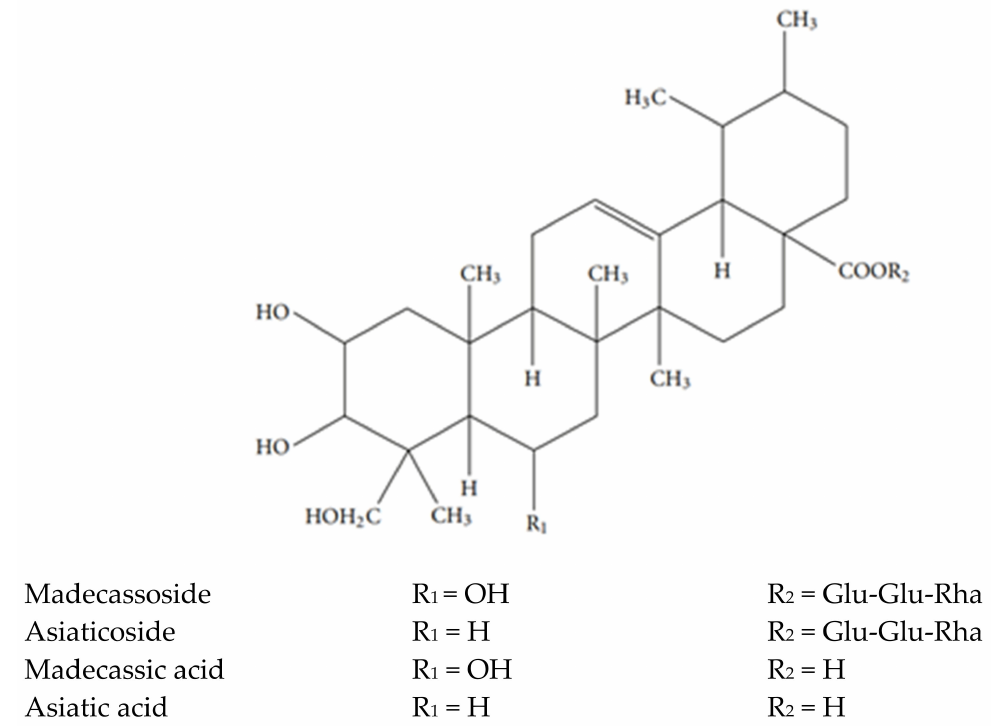
Figure 2. Chemical structures of madecassoside, asiaticoside, madecassic acid and asiatic acid (Glu: glucose, Rha: